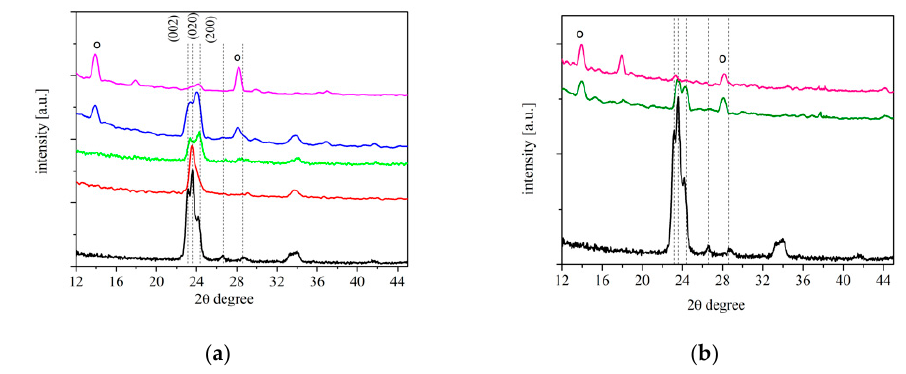
Figure 1. The GIXRD pattern for WO 3 and Fe-doped WO 3 thin films, respectively. ( a ) S1 sample: the red spectrum corresponds to S1 grown at T = 600 ◦ C; the green, blue, and magenta spectra belong to S1 samples annealed at T = 700, 720, and T = 750 ◦ C, respectively. ( b ) S2 sample: the dark green spectrum belongs to S2 grown at 720 ◦ C and the pink spectrum corresponds to S2 annealed to 750 ◦ C, respectively. The black spectrum corresponds to WO 3 deposited at T = 600 ◦ C. The dotted lines show the monoclinic plane positions of WO 3 . The circles correspond to hexagonal phase.